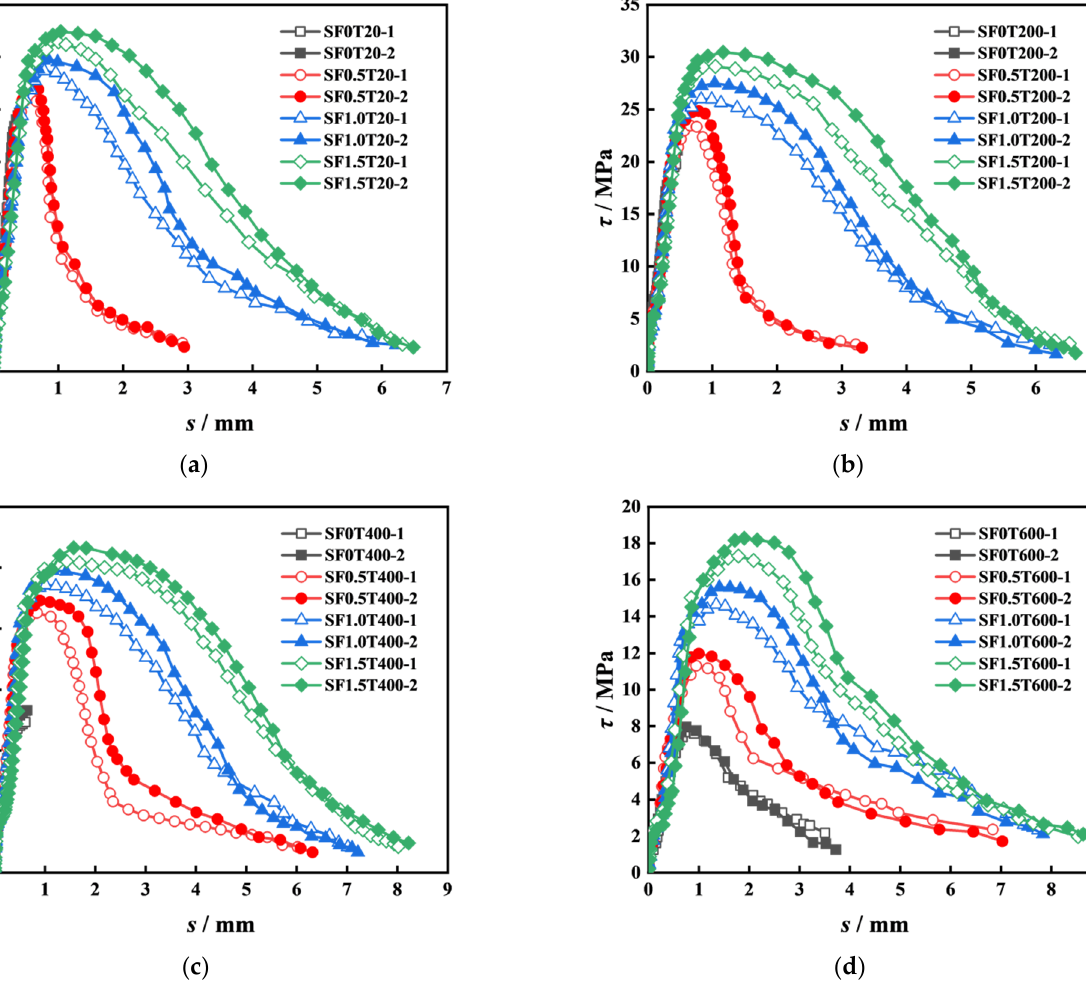
Figure 8. Bond–slip curves of specimens at ( a ) 20 °C, ( b ) 200 °C, ( c ) 400 °C, and ( d ) 600 °C.